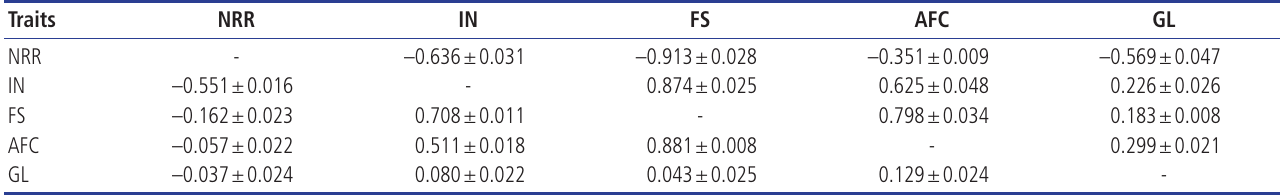
Table 5. Genetic correlation above diagonal and phenotypic correlation below diagonal (±standard error) among reproductive traits